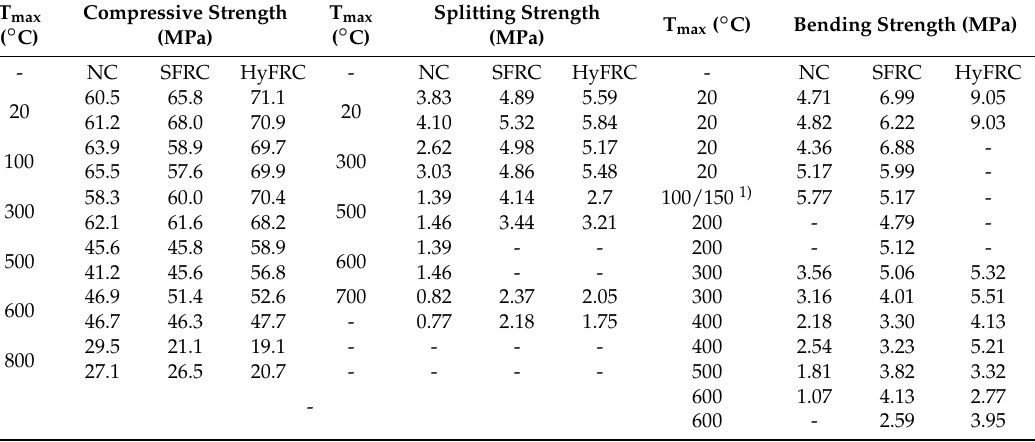
Table 3. Overview of the test results.